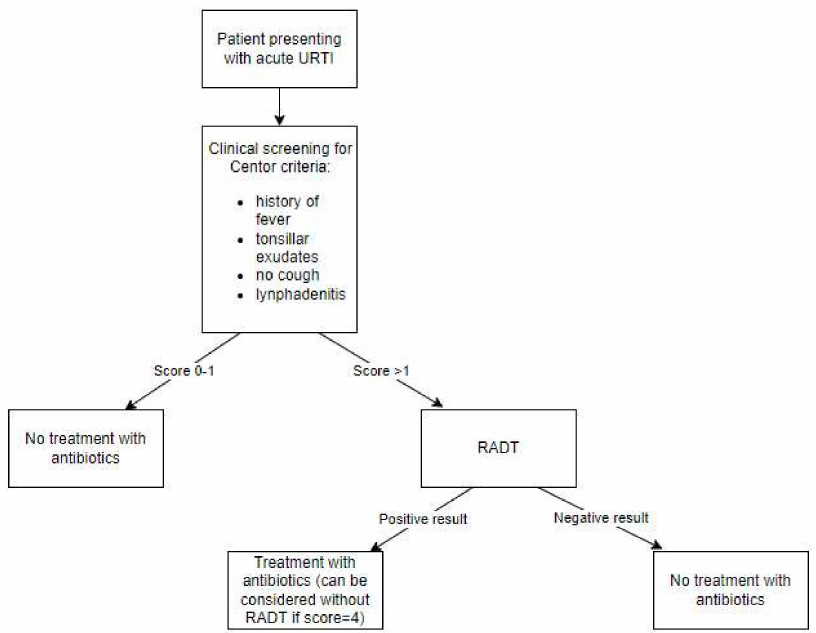
Figure 3. Flow chart summarizing the American Academy of Family Physicians (Leawood, KS, USA) guidelines for managing group A streptococcal pharyngitis (GAS) using a clinical scoring tool in combination with a rapid antigen-detection test (RADT) [29]. URTI: upper-respiratory-tract